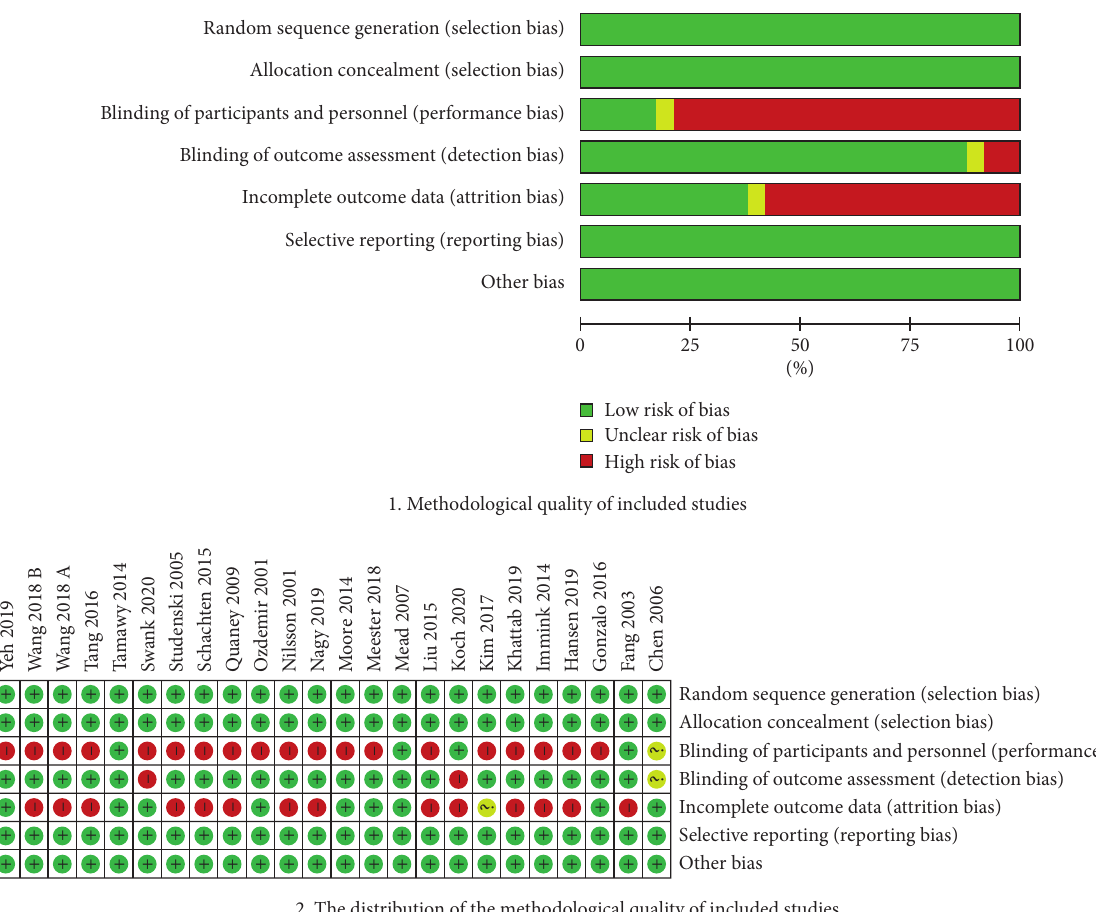
Figure 2: Quality assessment of included studies in the meta-analysis.